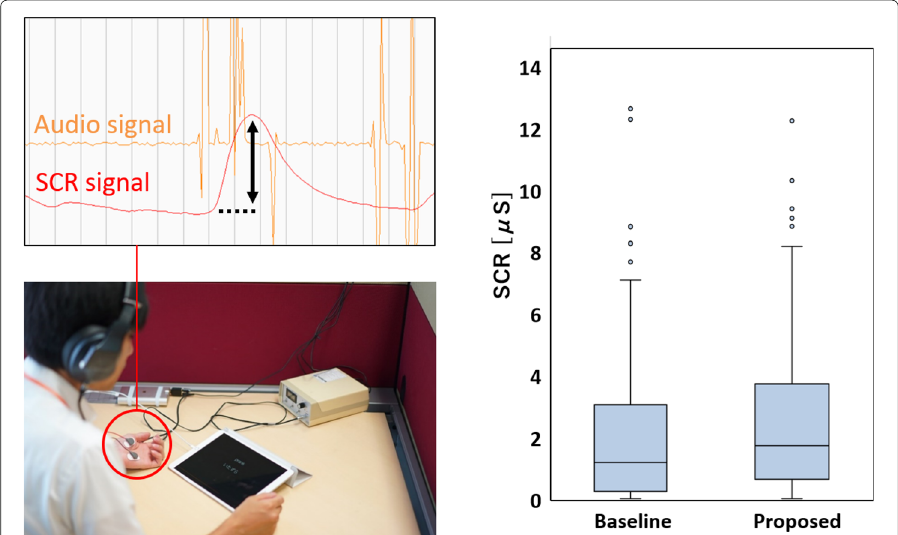
Fig. 5 Left: Electrodes attached to the participants’ palms and sample SCR data. Right: SCR value of the baseline and proposed